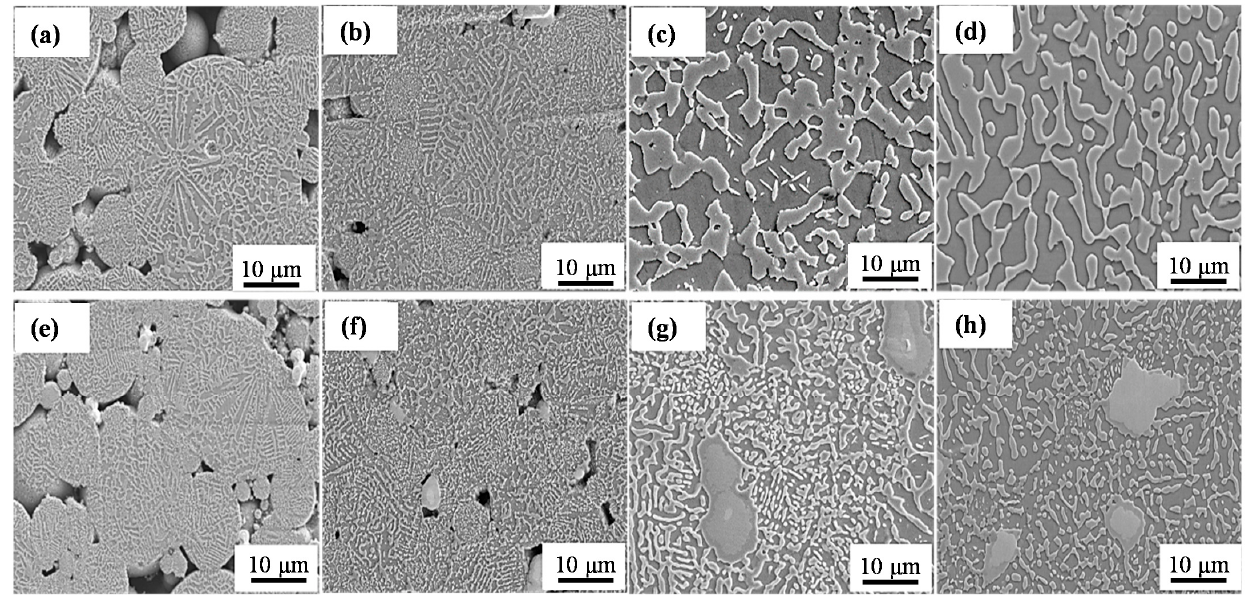
Figure 3. SEM images of the Co–Cr–W alloy and the Co–Cr–W matrix composites with different sintering temperature. ( a – d ) Co–Cr–W alloy; ( e – h ) Co–Cr–W matrix composites; ( a , e ) 1000 °C; ( b , f ) 1100 °C; ( c , g ) 1150 °C; ( d , h ) 1200 °C.